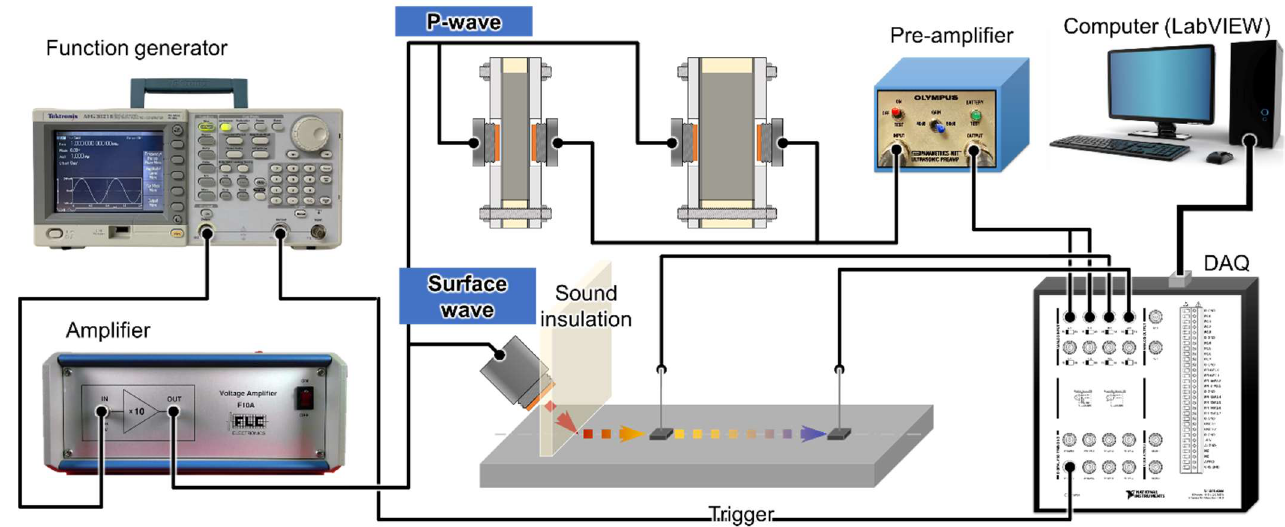
Figure 3. Overall testing configuration of both P-wave and surface wave.